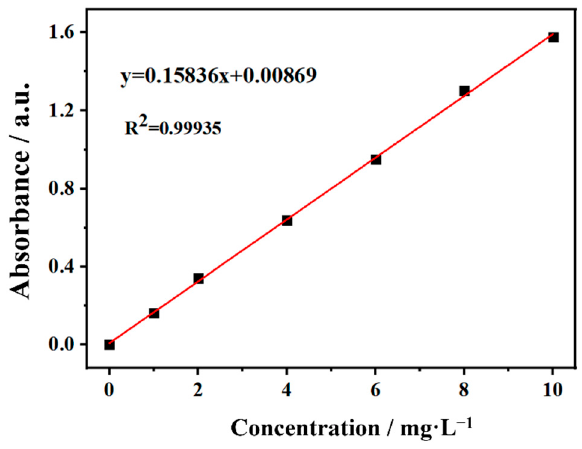
Figure 2. The standard working curve of MB